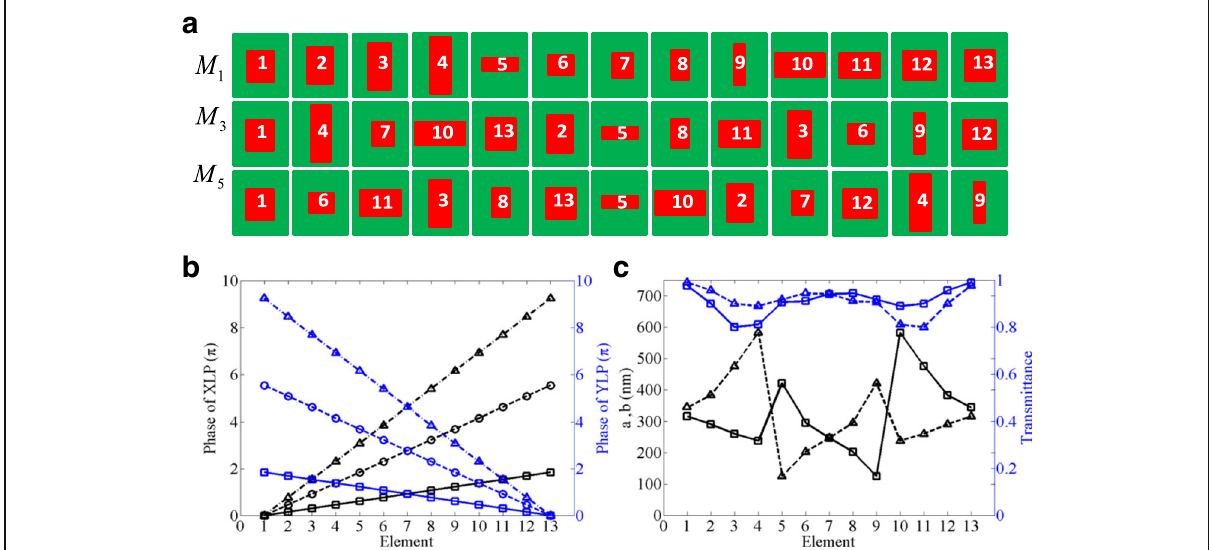
Fig. 2 Design of the dielectric metasurfaces with three different order diffraction modes. a Schematics of lateral dimensions of the 13 designed nanobricks. First line M 1 : a supercell with transmitted phase ranging from 0 to 2 π . Second line M 3 : a rearranged super cell with phase ranging from 0 to 3 × 2 π . Third line M 5 : a rearranged super cell with phase ranging from 0 to 5 × 2 π . b The simulated transmission phases of the 13 designed nanobricks of three different modes under XLP ( black lines ) and YLP ( blue lines ) incidences, respectively. c a ( black solid lines ) and b ( black dotted lines ) of the 13 nanobricks used in the designed metasurfaces M 1 . The blue lines represent the transmitted efficiencies of the 13 nanobricks in M 1 under XLP ( solid lines ) and YLP ( dotted lines ) incidences,